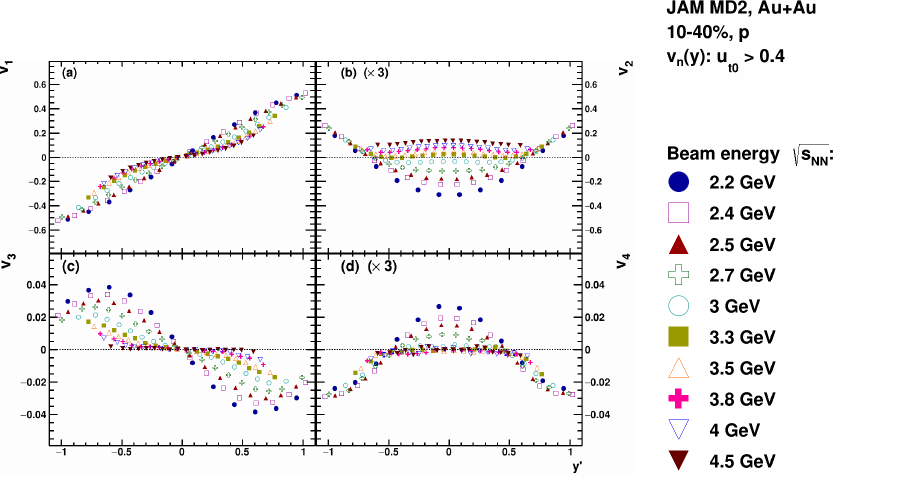
Figure 16. Scaled rapidity ( y (cid:48) = y cm / y beam ) dependence of anisotropic flow coefficients v 1 , v 2 , v 3 and v 4 of protons ( a – d ) in the 10–40% central Au + Au collisions at symbols correspond to the v n ( p T ) results obtained for different beam energies from √ s NN = 4.5 GeV (brown down-pointing triangles) using the JAM model with (blue closed circles) to hard momentum dependent mean-field MD2 ( K 0 = 380 MeV)